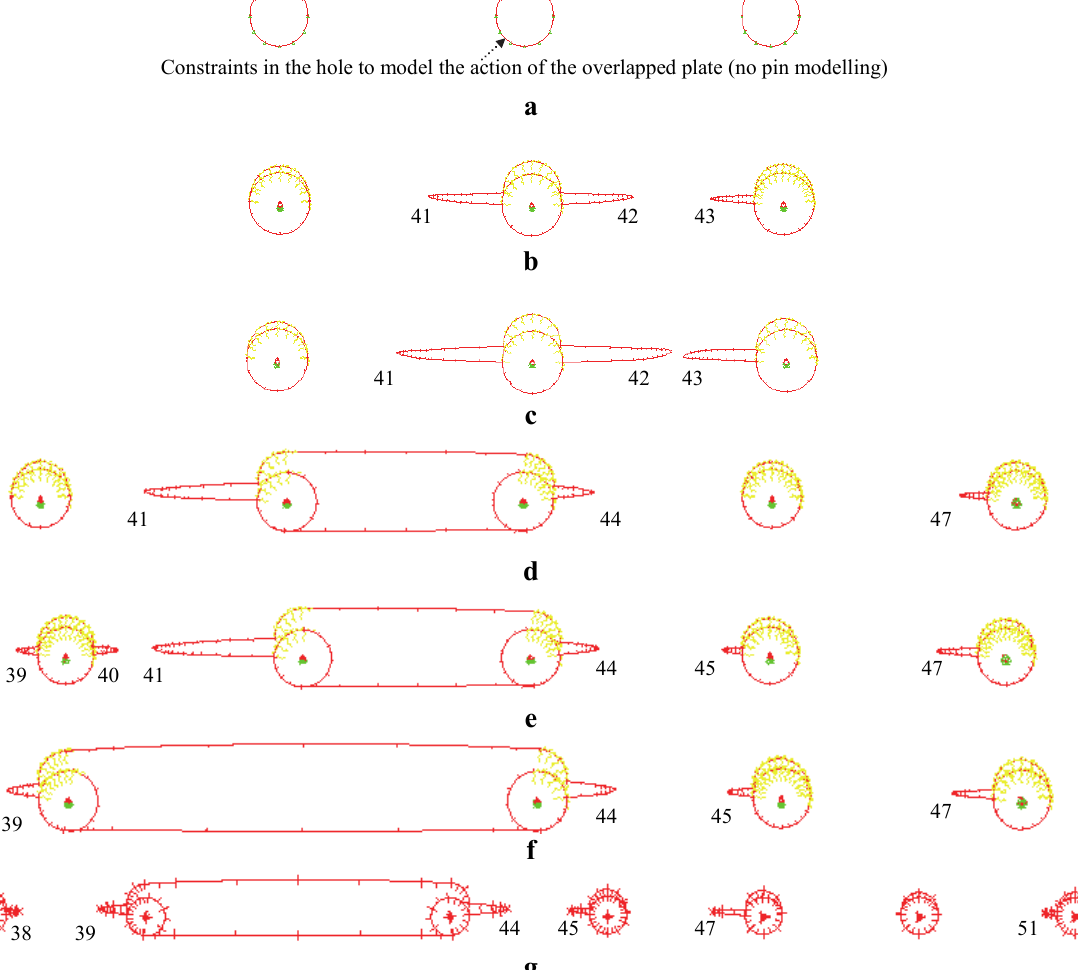
Figure 5: Deformed shape (scale factor 20) of multiple crack scenario after a number of cycles equal to: 73500 (a), with initial cracks (tip N. 41 and 42) as recorded by the experimenter; 84000 (b) with a new recorded initiation (tip N. 43); 99500 (c) with propagation of the previously indicated cracks and a new recorded initiation (tip N. 47); 105770 (d) with a link-up between tips N. 42 and 43 and corresponding new postulated initiation (tip N. 44); 108000 (e) with new recorded initiations (tip N. 39, 40 and 45); 110500 (f) with a link-up between tips N. 40 and 41 and a new recorded initiations (Tip N. 51); 112000 (g) with new recorded initiations (Tip N.